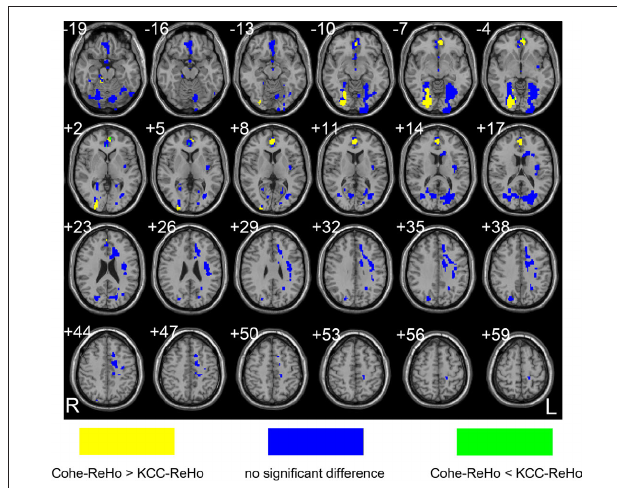
FIguRe 7 | Cohe-ReHo and KCC-ReHo had different sensitivity to the difference in local synchronization between ADHD and control groups. Yellow color means Cohe-ReHo is more sensitive than KCC-ReHo. The green color means the opposite direction. The blue color means that the two measurements have no significant difference in their sensitivity in detecting differences between the two groups. The left side of the image corresponds to the right side of